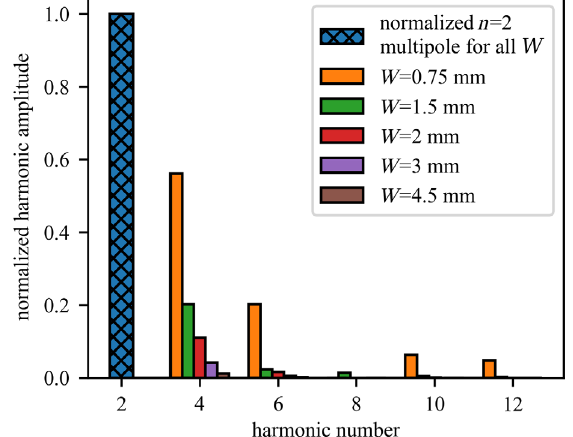
FIG. 3. A 2D harmonic analysis of the device as a function of width was computed using COMSOL Multiphysics. All multipoles are normalized to the n ¼ 2 quadrupole moment (blue hatched bar). The gap was set to 1.5